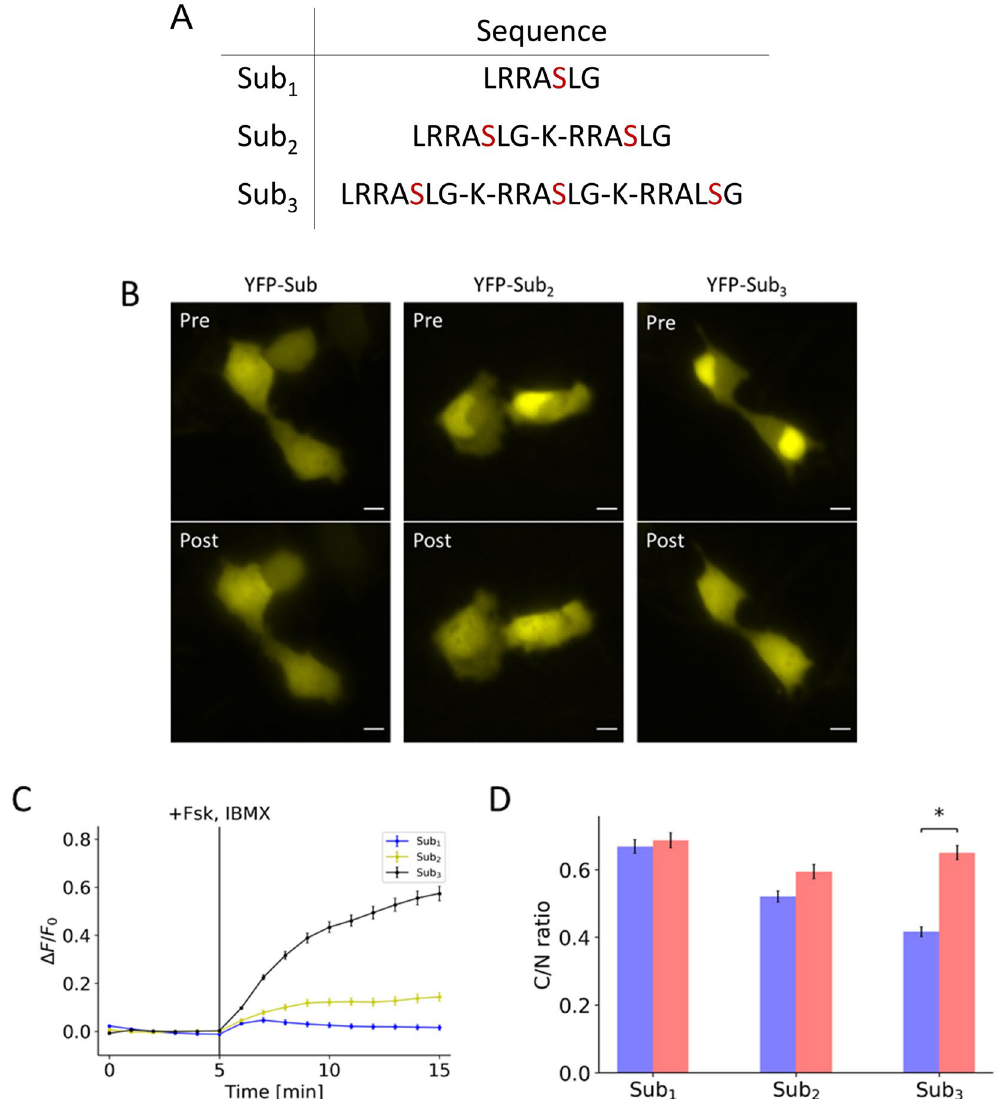
Figure 1. Effects of valency on initial localization and response to PKA activation. ( A ) Table contains the amino acid sequences of the peptides containing the different number of substrates. ( B ) Representative images of peptides containing one, two, and three substrates, each of which is fused to a yellow fluorescent protein (YFP), show the initial distribution (Pre) and the distribution 10 minutes post-treatment (Post) of 50 µ M forskolin and 100 µ M IBMX. ( C ) Response profile shows the normalized fluorescence signal change resulting from the activation of PKA for peptide consisting of one (blue), two (yellow), and three (black) substrates. ( D ) Bar chart represents the pre-treatment localization (blue) and post-treatment localization (red) as measured by taking the ratio of cytosol-to-nuclear fluorescent signal for peptide consisting of one, two, and three substrates. All data points in this figure represent an average signal intensity calculated from 30 cells over 3 independent experiments. Error bar represents standard error of mean. * represents p < 0.001. Scale bar represents 10 µ